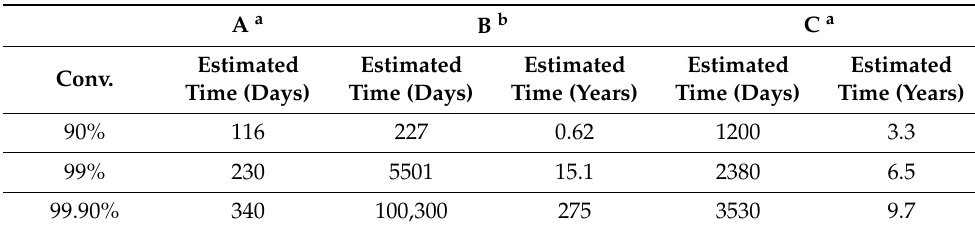
Table 1. Calculation of the final biodegradation time corresponding to the conversion of 90, 99 and 99.9% conversion for the different materials.